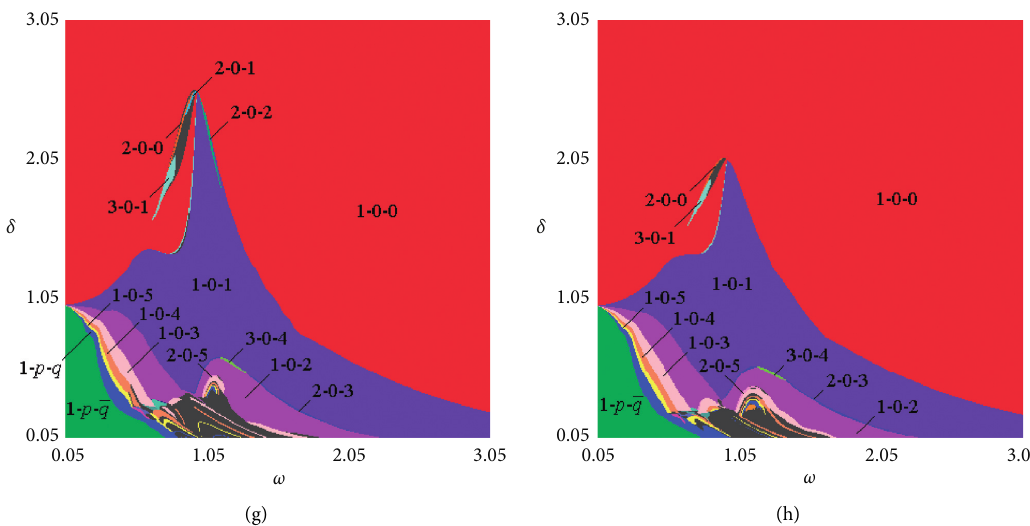
Figure 11: Under different damping coefficient ζ , the system presents dynamic characteristics in the ( ω , δ ) -parameter plane. : ζ � 0.06; (b) M (a) M 1